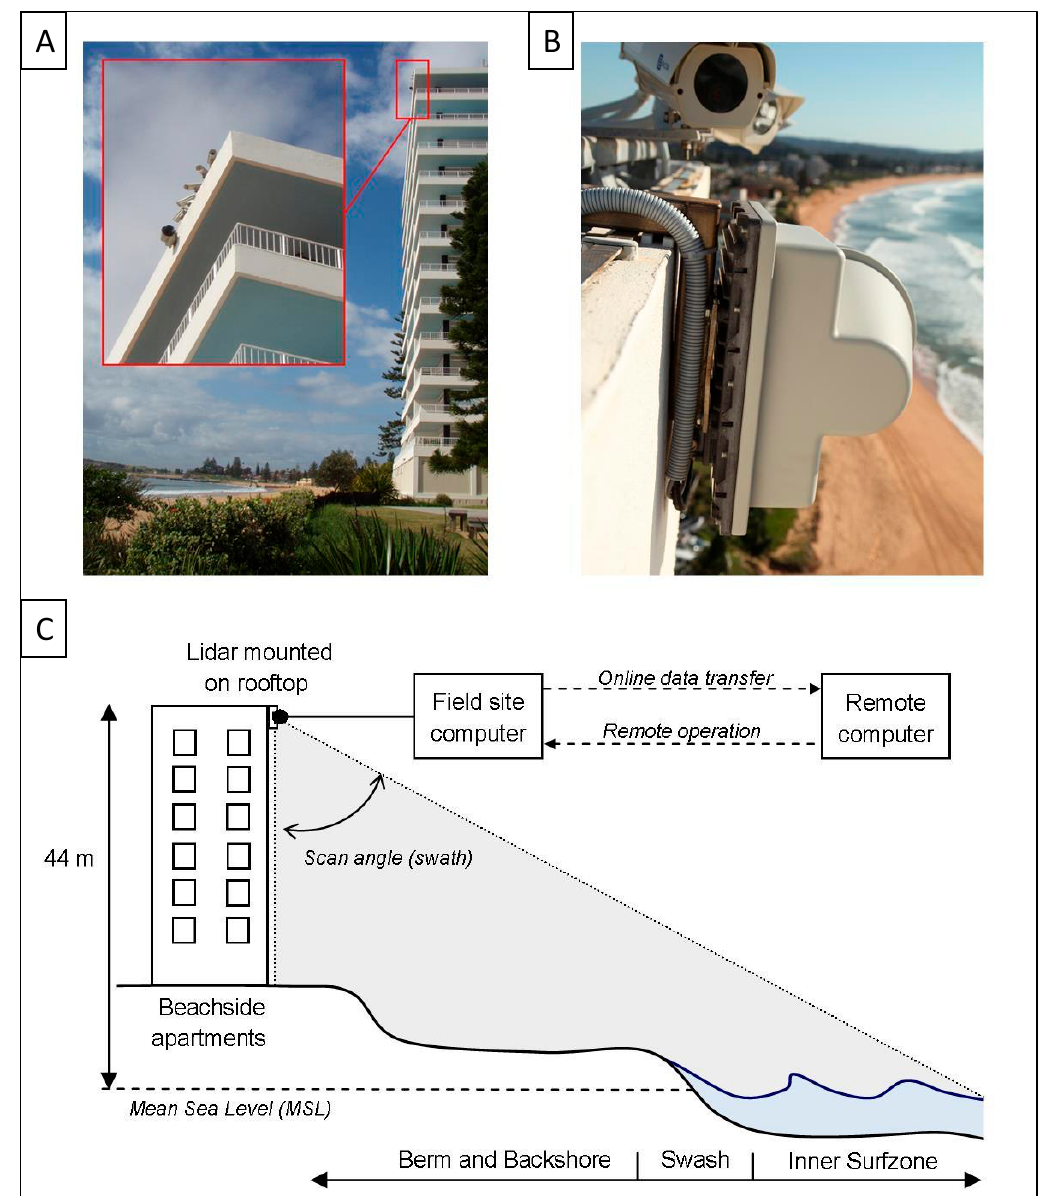
Figure 7. Fixed Lidar monitoring system photographs ( A , B ) showing Lidar instrument mounted on rooftop of beachside apartment building just below the Coastal Imaging station at Narrabeen-Collaroy Beach, SE Australia. ( B ) Schematic of lidar setup. Source: M. Phillips PhD Thesis (UNSW Sydney, 2018).